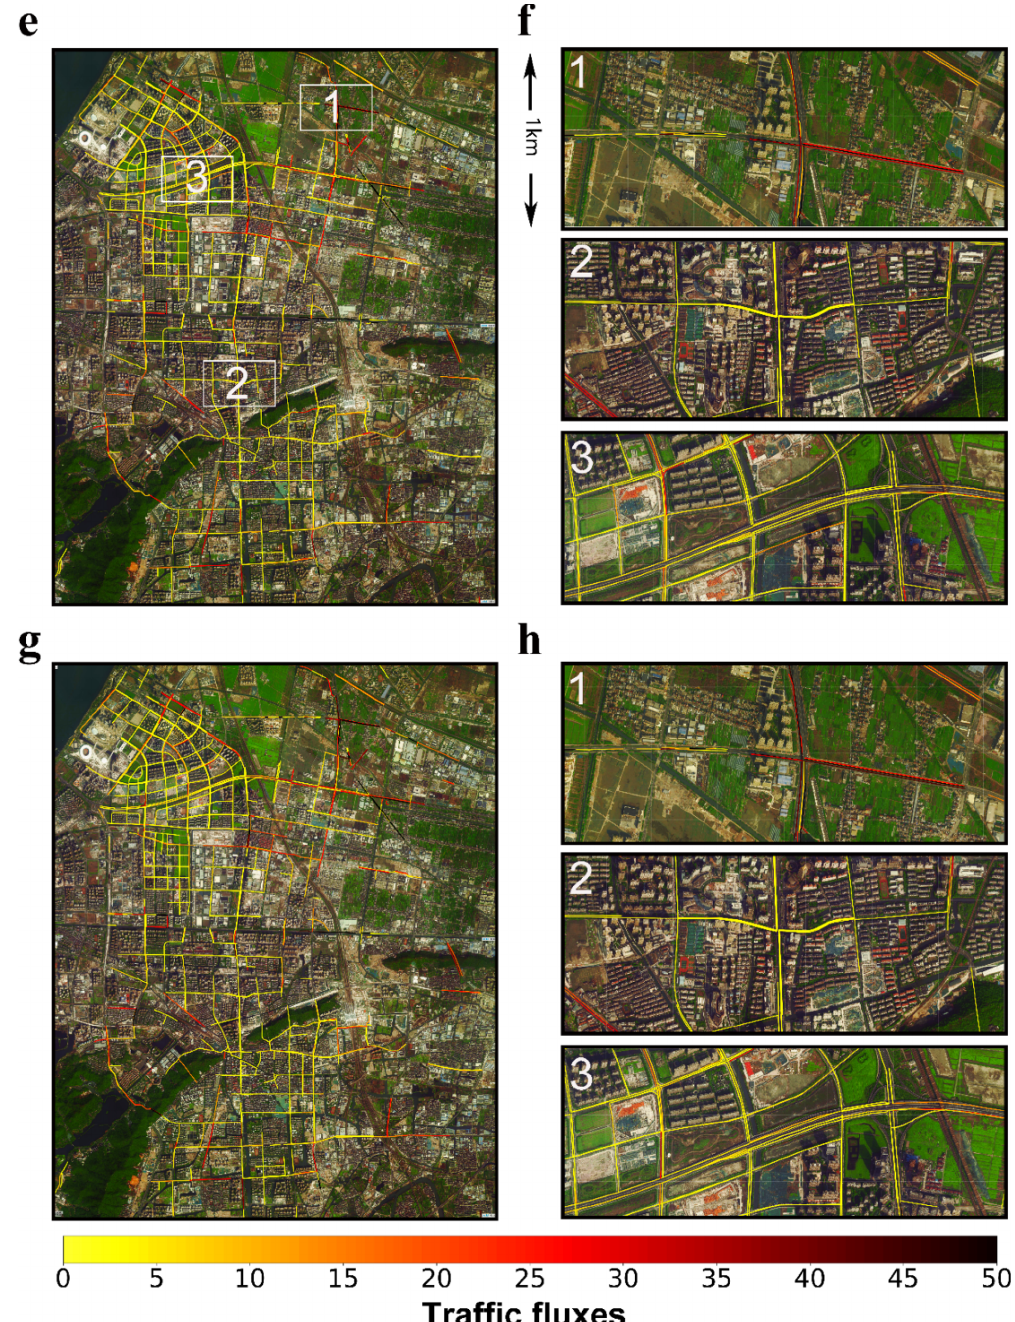
Figure 3. Hyperfine-resolution mapping of observed traffic fluxes. (a) Hourly average traffic fluxes in each road segment based on 2-month traffic monitoring data over the entire district and (b) for three indicative 1km 2 urban zones therein. The panels (c) and (d) are the same as (a) and (b) but for the hourly average traffic fluxes during the morning and evening rush hours (from 07:00 to 09:00 and from 16:30 to 18:30 local time) on weekdays (from Monday to Friday). The panels (e) and (f) are as the same as (a) and (b) but for the hourly average traffic fluxes of HDVs and HDTs. The panels (g) and (h) are as the same as (c) and (d) but for the morning and evening rush hours on weekdays. The indicative zones are marked by white rectangles in (a) , and their spatial scales are presented in (b) . Illustrative traffic hotspots (white-outlined rectangles) are also annotated in (a) , including Tonghui North Road, Hongda Road, Shixin North Road, Shanyin Road, and Airport Road. Map data © 2021, Gaode